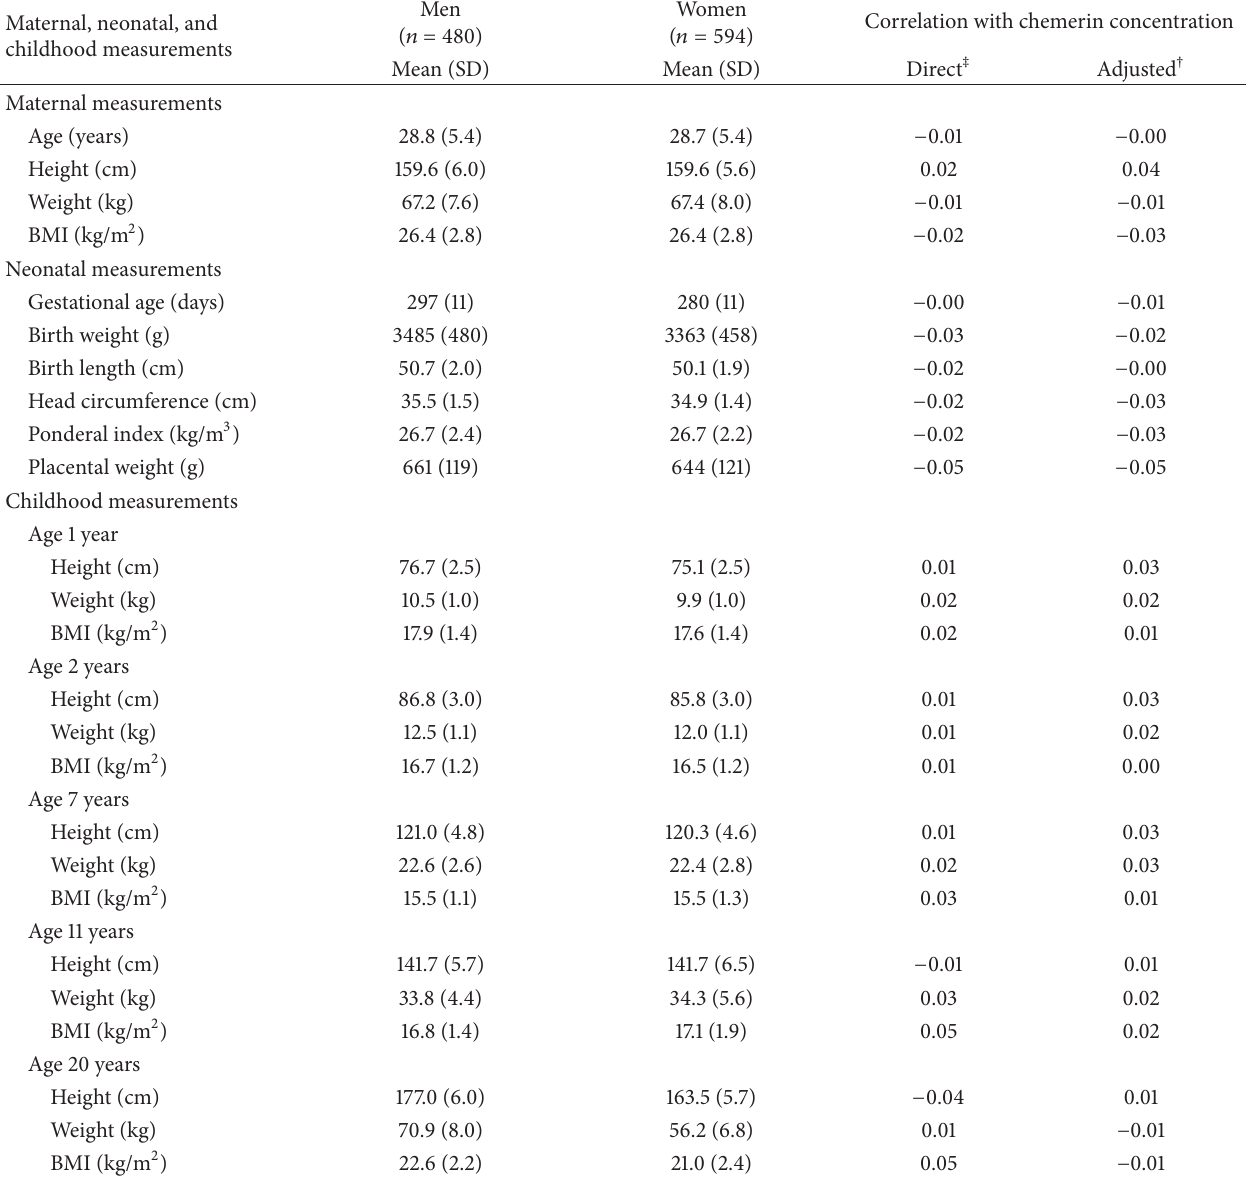
Table 2: Descriptive data for maternal, neonatal, and childhood measurements and correlations with chemerin concentration. Maternal, neonatal,